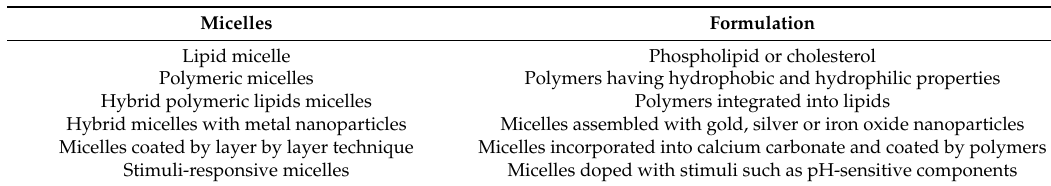
Table 1. Micelles modification